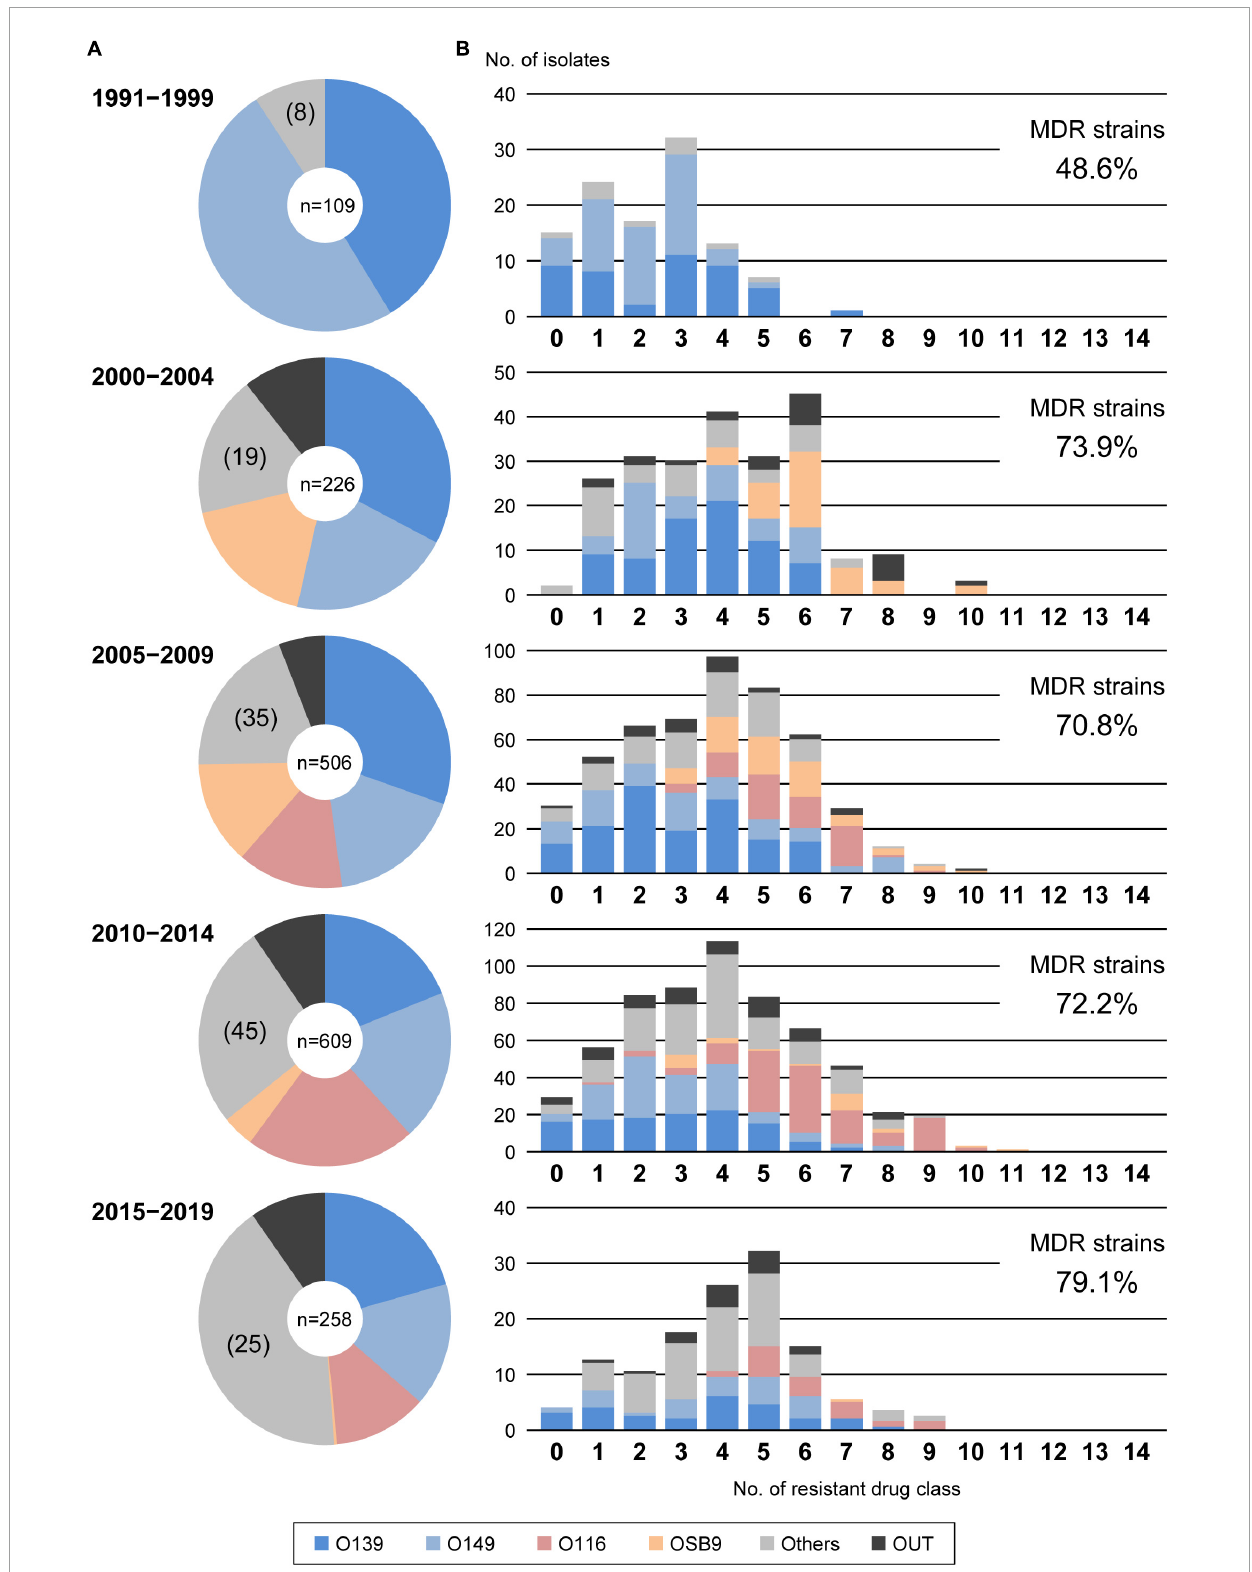
FIGURE1 Temporal changes in O serogroups (A) and multidrug resistance levels among each O serogroup (B) in E. coli isolated from diseased swine in Japan. The O serogroup prevalences and multidrug resistance levels between 1991 and 1999, 2000 and 2004, 2005 and 2009, 2010 and 2014, and 2015 and 2019 were compared. O serogroups are indicated with the following colors: blue, O139; light blue, O149; pink, O116; orange, OSB9; dark gray, untypeable (OUT); and gray, O serogroups other than O139, O149, O116, OSB9, and